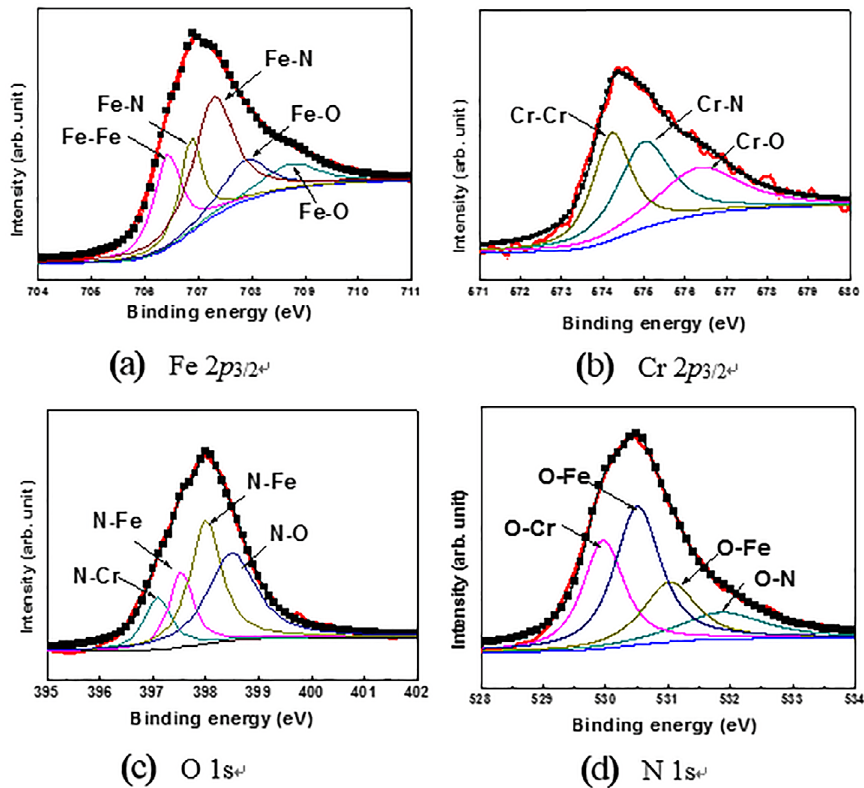
Figure 7 . XPS spectra of Fe 2 p 3/2 (a), Cr 2 p 3/2 (b), O 1s (c) and N 1s (d) level obtained surface of the 440°C oxy-nitrided sample after a sputtering depth 2nm.